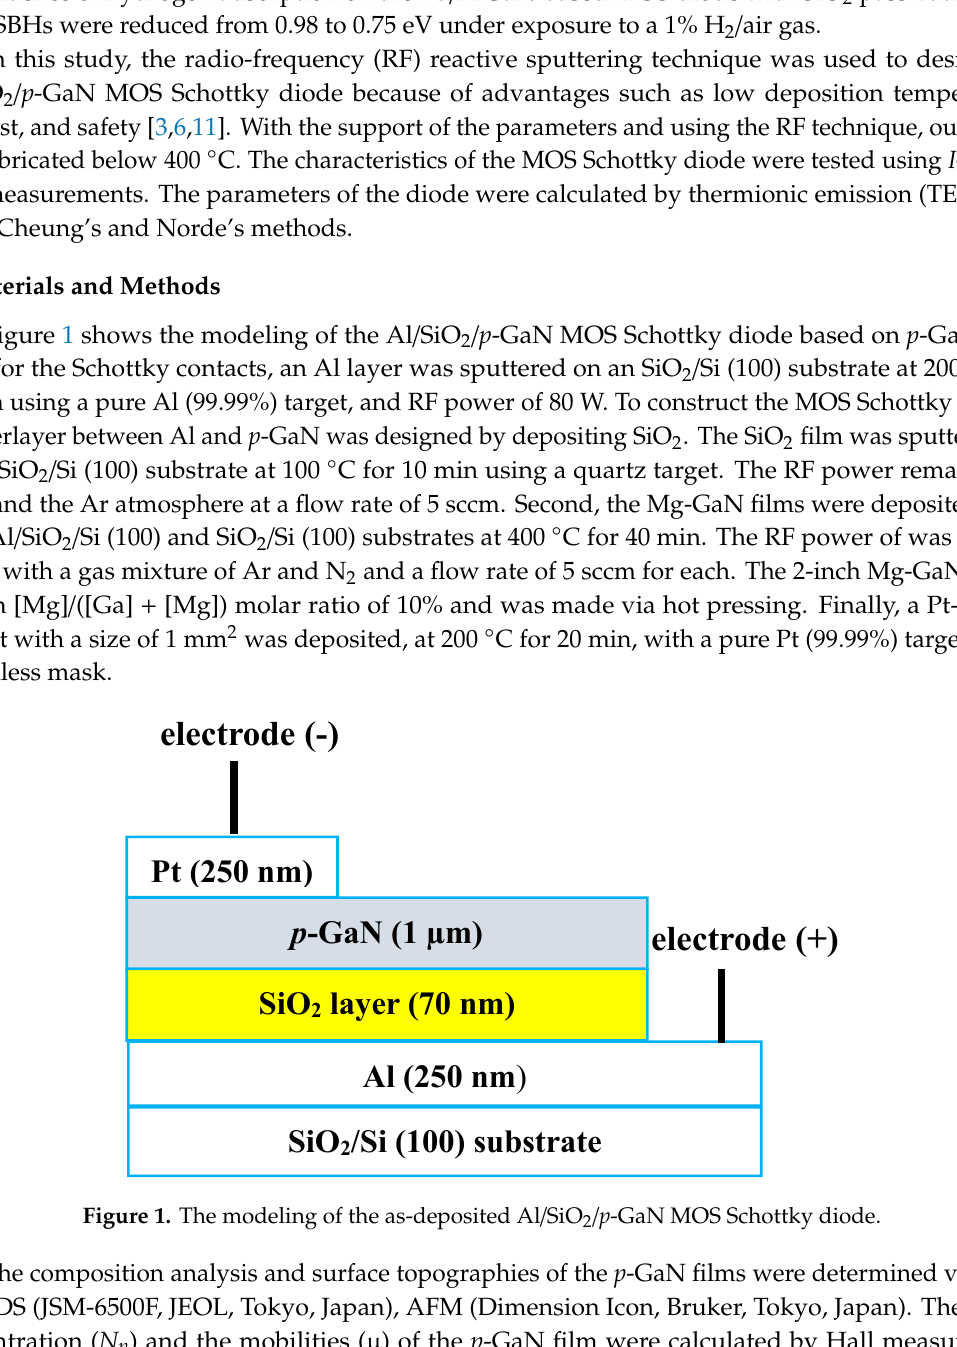
Figure 1. The modeling of the as-deposited Al/SiO 2 / p -GaN MOS Schottky diode.